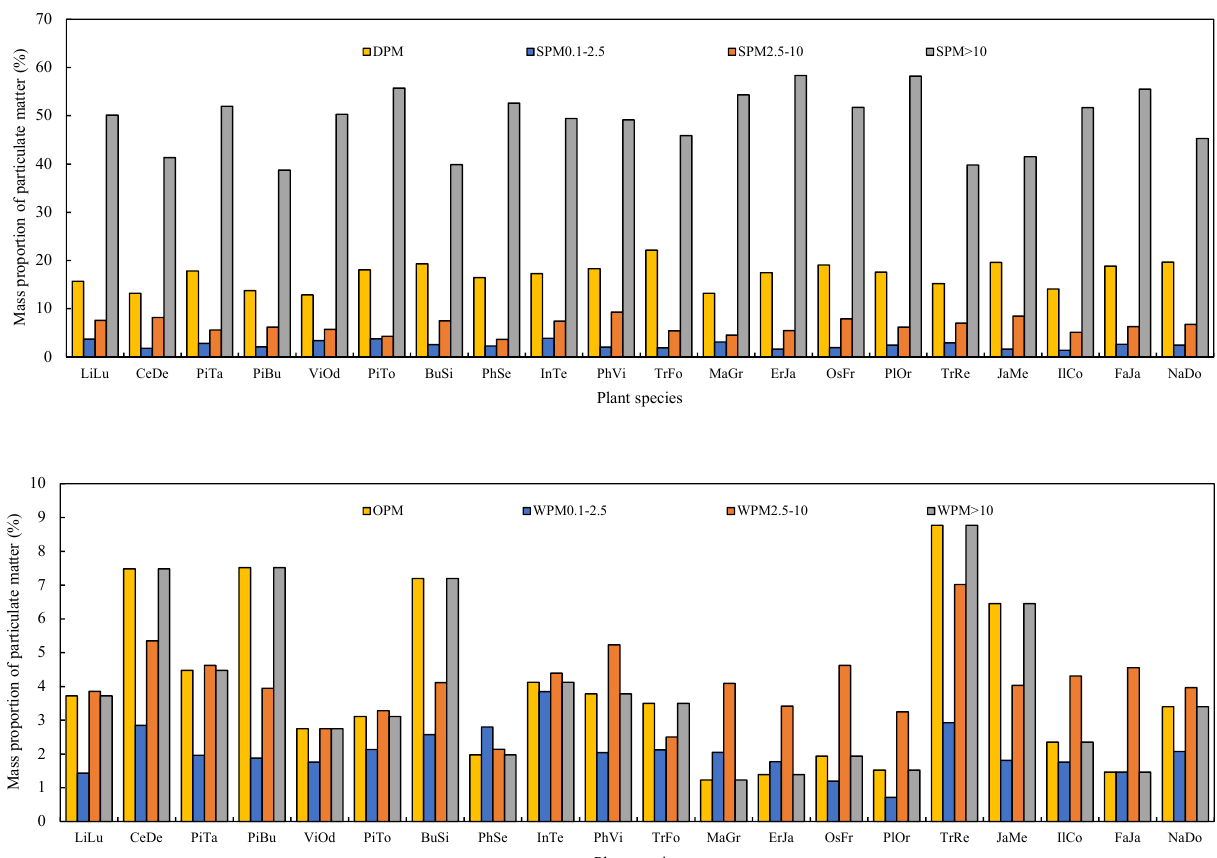
Figure 2. The mass proportions of eluted by water and brushing (SPM), chloroform and brushing (WPM) within different diameter classes (diameter > 10 µ m, 2.5–10 µ m, 0.1–2.5 µ m), water-soluble (DPM), and organic-soluble (OPM) particulate matter retained on the investigated leaves.